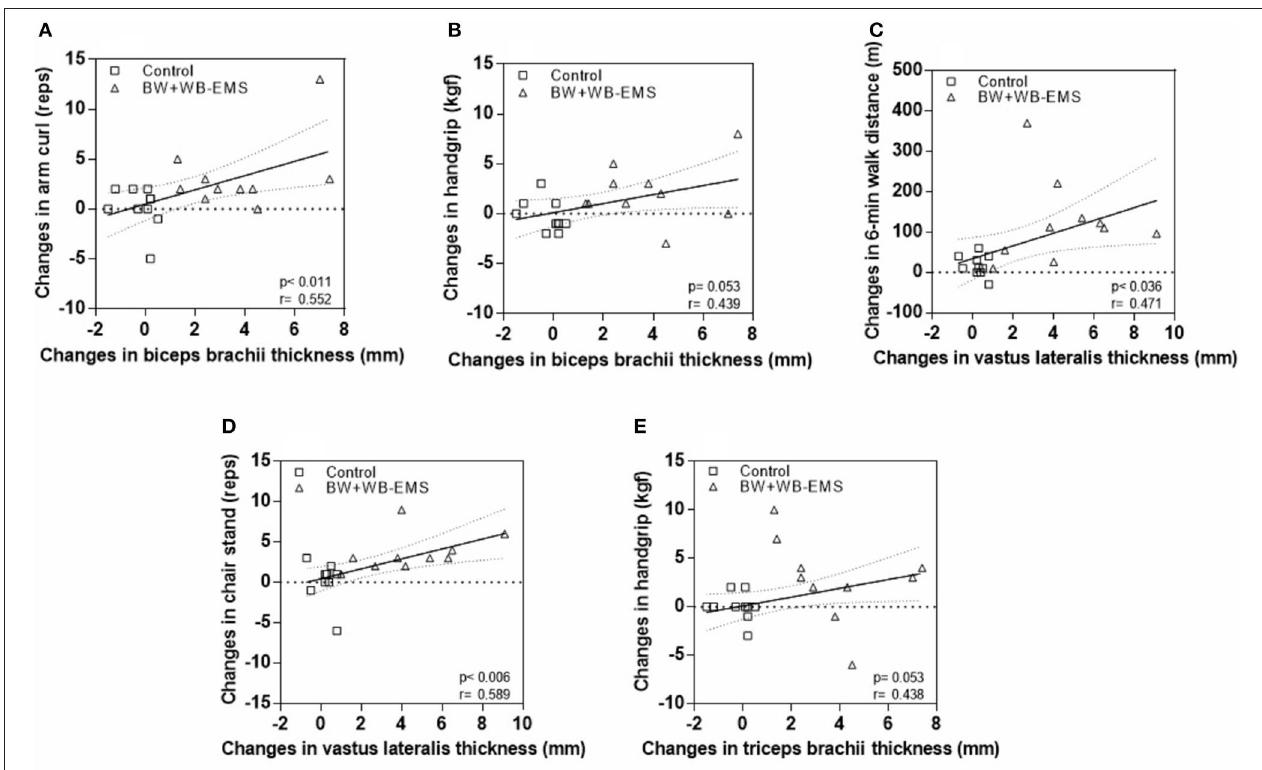
FIGURE 4 | Correlations between changes in functional fitness and muscle thickness parameters. (A) Changes in biceps brachii thickness and arm curl. (B) Changes in biceps brachii thickness and handgrip. (C) Changes in vastus laterais thickness and 6-min walk distance. (D) Changes in vastus laterais thickness and chair stand. (E) Changes in triceps brachii thickness and